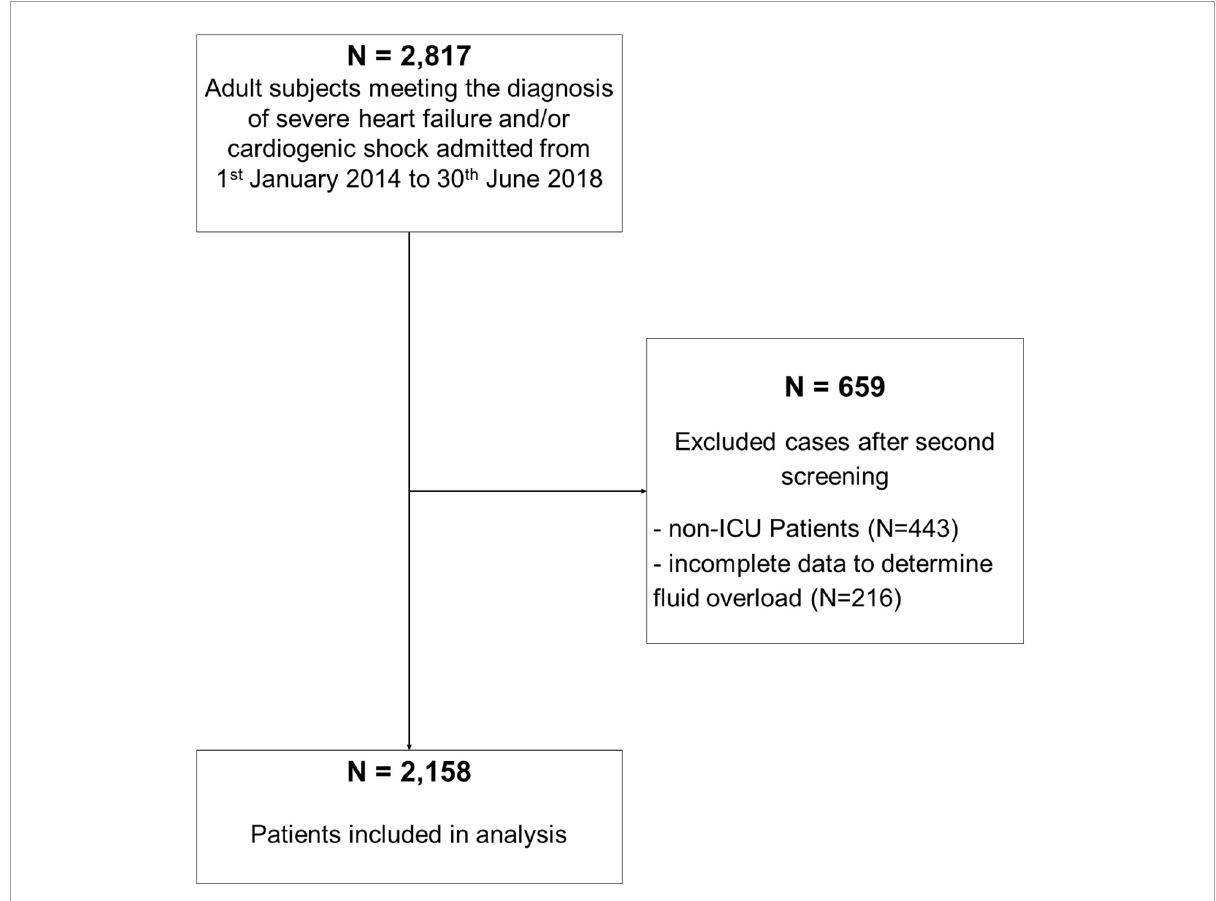
FIGURE1 Strobe flowchart. ICU, intensive care